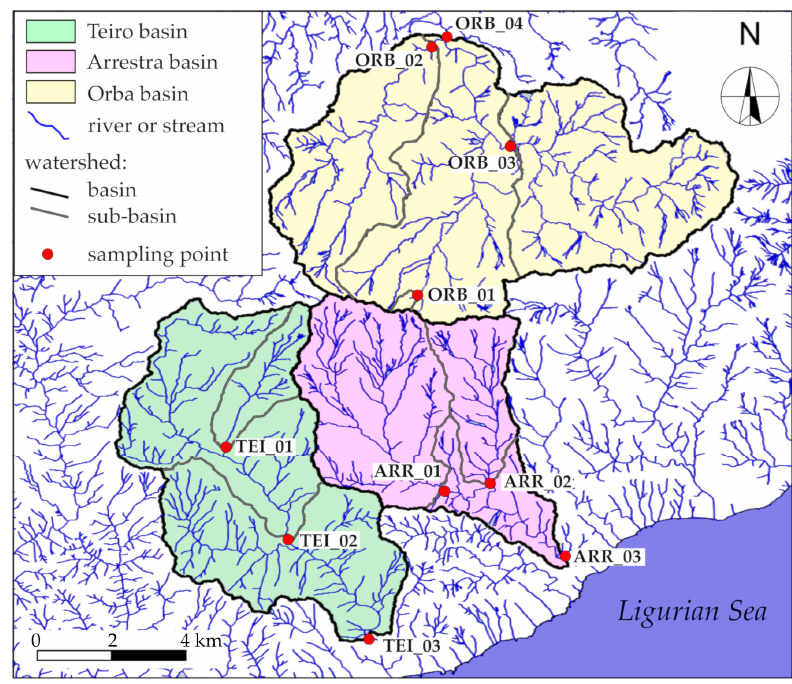
Figure 2. Drainage basins and location of the sampling points.